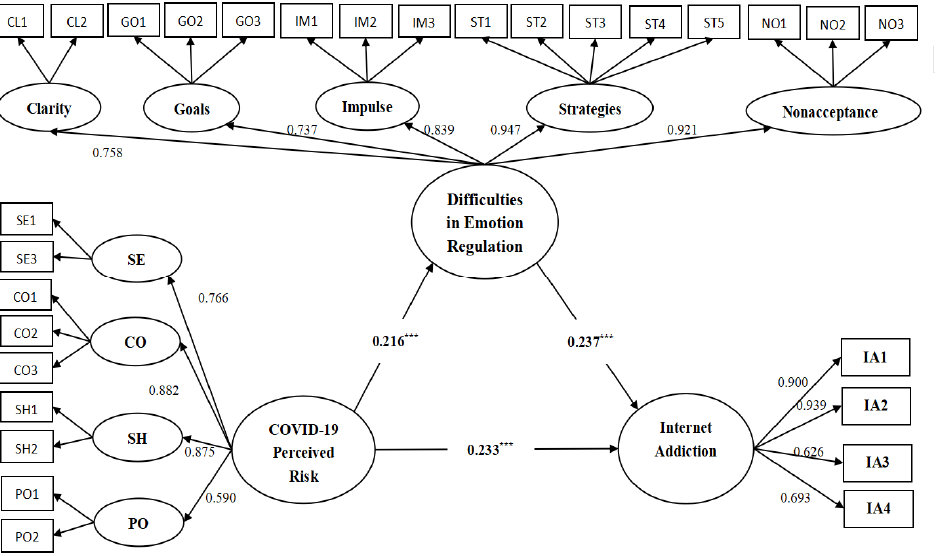
Figure 2. The Mediation Model. Note: *** p < 0.001; SE, Severity of the epidemic; CO, Controllability; SH, Severity of the health effects; PO, Possibility; IA, Internet Addiction; CL/Clarity, Lack of Emotional Clarity; GO/Goals, Difficulties Engaging in Goal-Directed Behavior; IM/Impulse, Impulse Control Difficulties; ST/Strategies, Limited Access to Effective Emotion Regulation Strategies; NO/Nonacceptance, Nonacceptance of Emotional Responses.